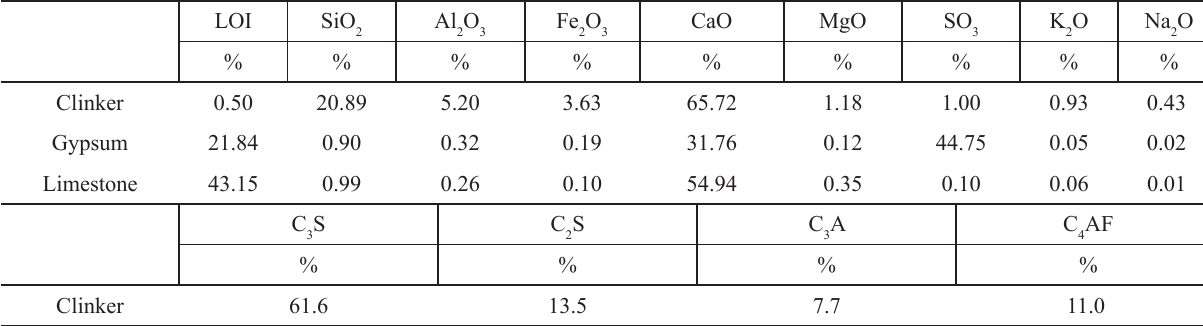
Table 1 – Materials chemical analyses and clinker mineral